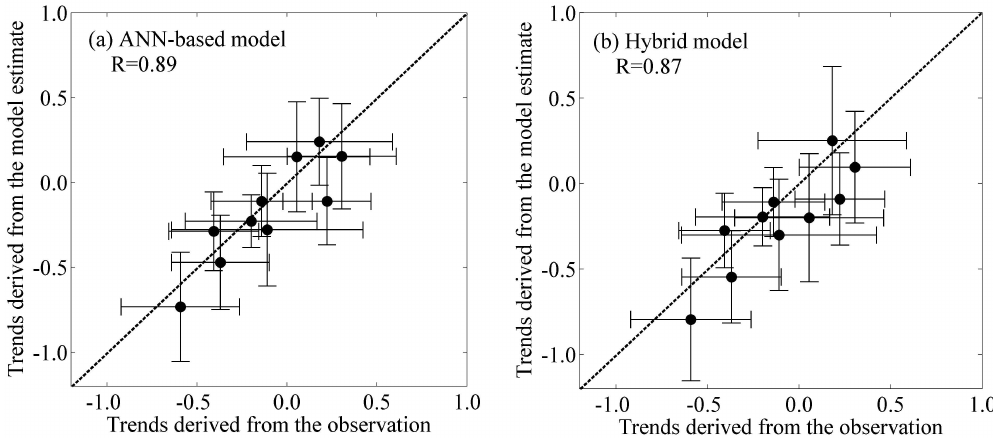
Fig. 3. Comparison of solar radiation trend slopes at ten validation stations during 1979 ∼ 2006: (a) between the observation and the ANN- based model estimate, and (b) between the observation and the hybrid model estimate. The filled black circles denote trend slopes, and the bars denote the 95% confidence intervals of the estimated trend slopes. The unit of the trend is Wm − 2 yr − 1 .